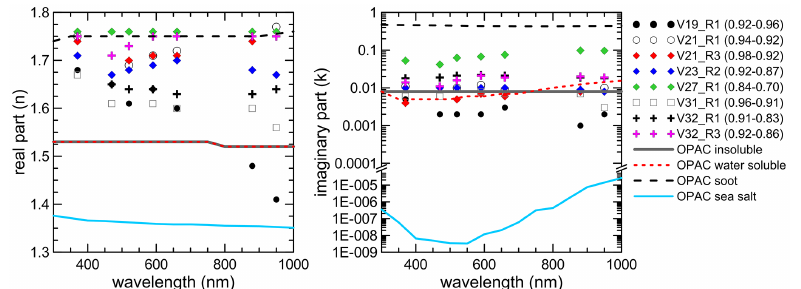
Figure 8. Spectral real ( n , left panel) and imaginary ( k , right panel) parts of the complex refractive index obtained by optical closure for the eight selected case studies. For the sake of clarity, uncertainties on n and k are not reported in the plot. The values of the single scattering albedo measured at 370 and 950nm for the different cases are reported in the legend. The spectral real and imaginary parts of the complex refractive index as obtained from the Optical Properties of Aerosols and Clouds (OPAC, Hess et al., 1998) database for insoluble, water soluble, soot and sea salt components are also reported in the plot. These components are used in OPAC to model continental polluted, continental rural, urban, and maritime polluted aerosols. Table 4. Maximum, mean, and minimum of the single scattering albedo considered for radiative transfer calculations. Values are reported at the seven wavelengths used as inputs in the GAME model. 330nm 400nm 550nm 670nm